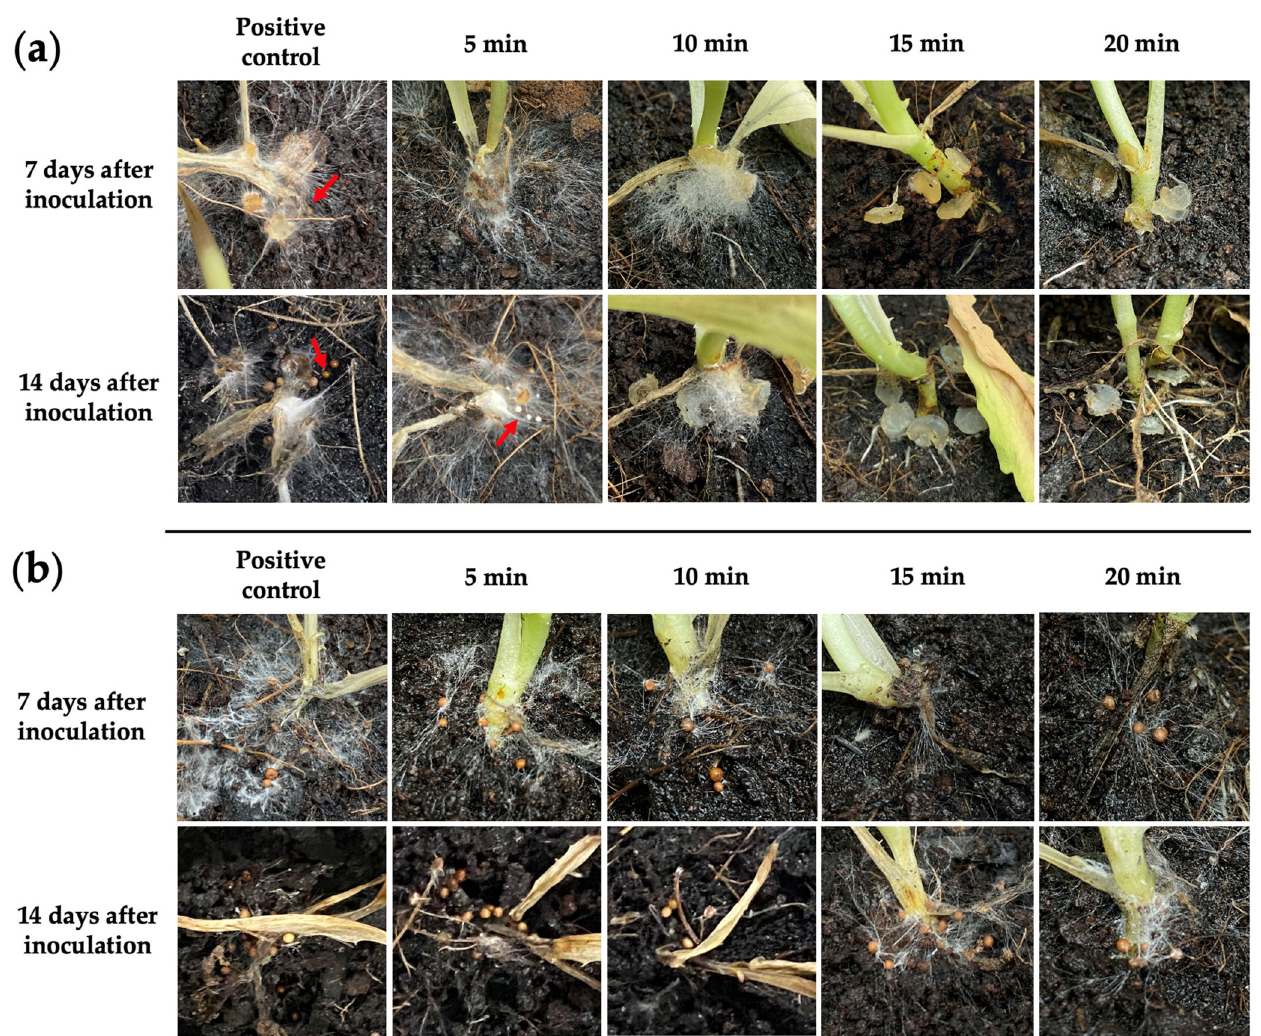
Figure 6. Characteristics and growth of mycelial discs and sclerotia, which were inoculated to lettuce after exposure to the DBD plasma at 5, 10, 15, and 20 min, photographed at 7 and 14 days after ( a ) mycelial disc inoculation (the formation of sclerotia is indicated by red arrows) and ( b ) sclerotia inoculation.